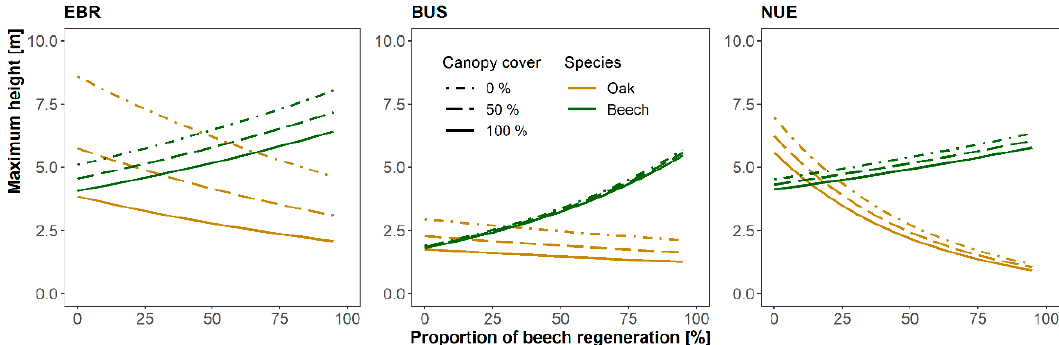
Figure 6. Estimated maximum heights of oak and beech regeneration as a function of the proportion of beech regeneration and canopy cover at the age of 20 (Equation (5)); shown are the height trajectories of oak and the most competitive beech species. Note the different scaling of the x- axes.